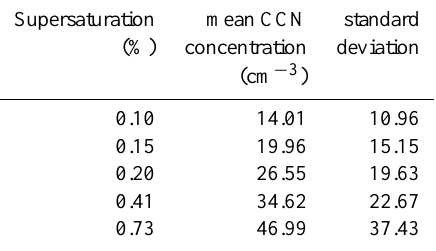
Table 3. The mean CCN concentrations and standard deviations for all five measured supersaturations of counter 1, averaged over the time period of the ice